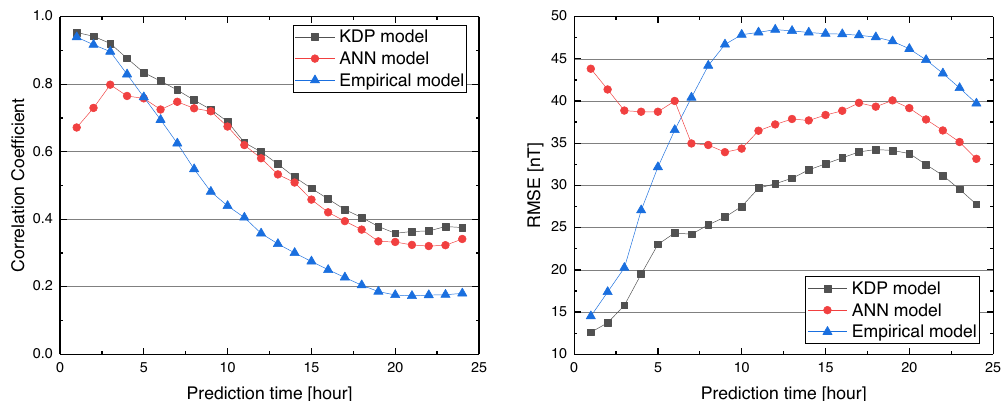
Fig. 7. Correlation coef fi cient and RMSE for the empirical model, ANN model, and combination (KDP) model. The performances were calculated only for the storm events in test group.